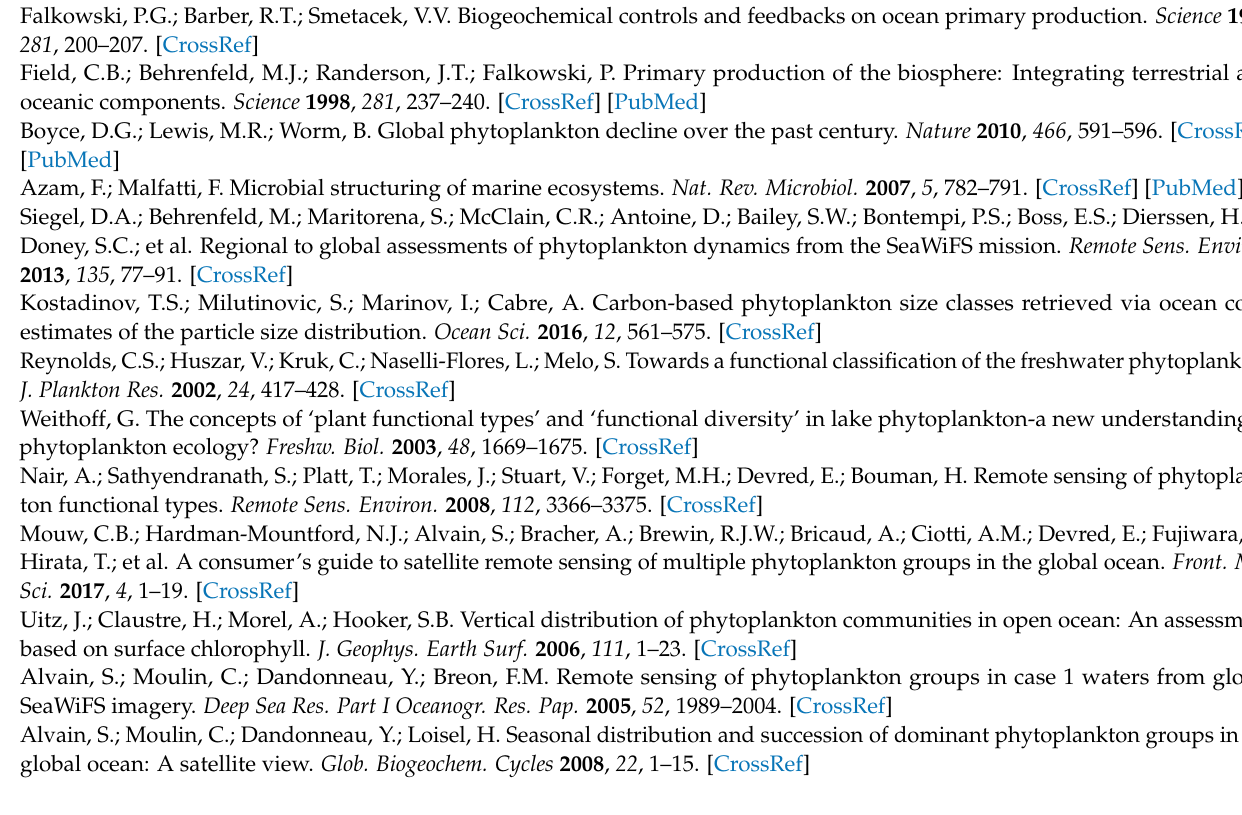
Figure S12. Q–Q plots of